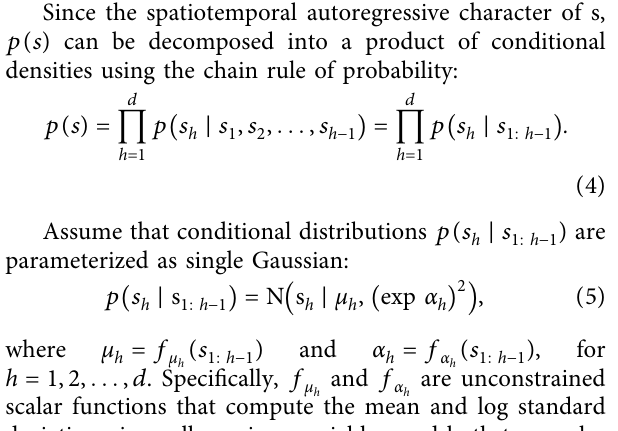
to t are shown in Figure 2 (a) An illustration of t 1 3